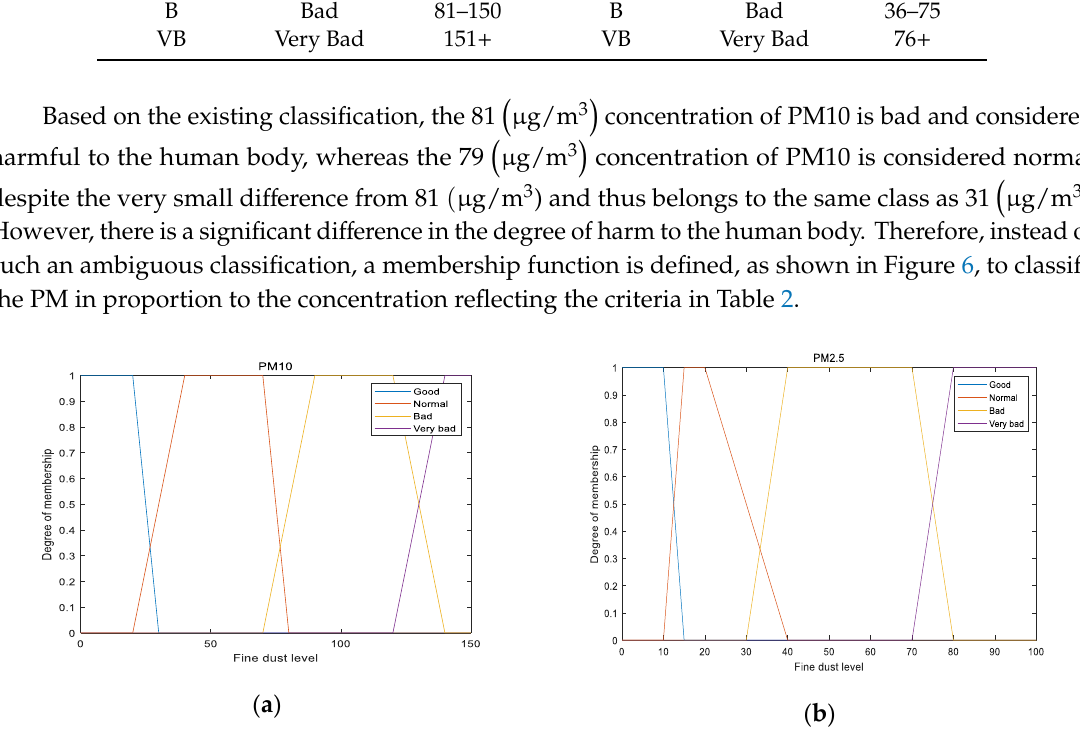
Figure 6. Input membership function for ( a ) PM10 and ( b ) PM2.5.